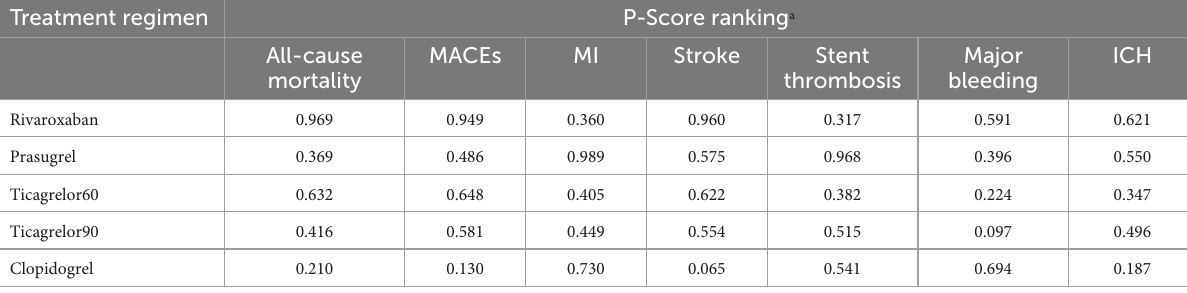
TABLE 2 P-Scores for the treatment regimens and outcomes. Treatment